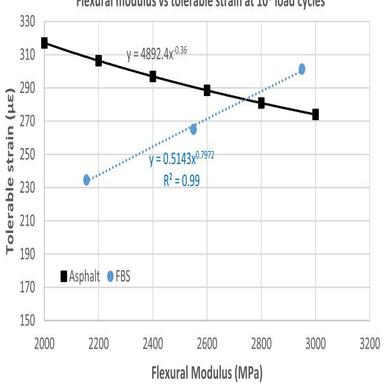
Comparison of tolerable strain values against flexural modulus for asphalt (Vb = 6%) and FBS materials (when the flexural modulus is a function of density).